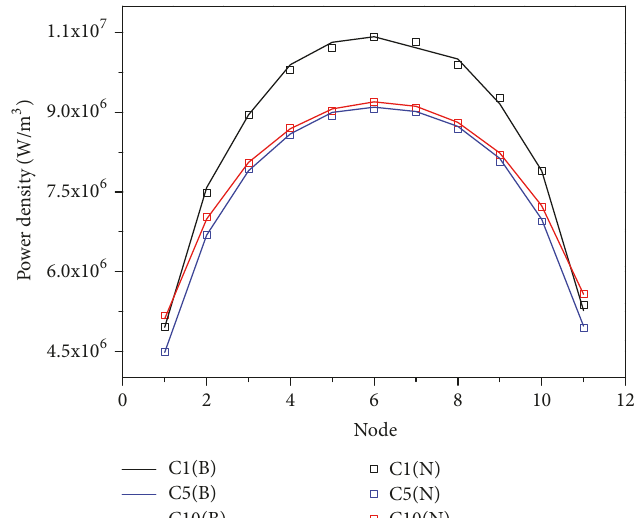
Figure 10: Power density distribution of fuel salt for the C1, C5, and C10 assemblies (line represents the situation of central fuel assembly partly blocked and square represents normal operating